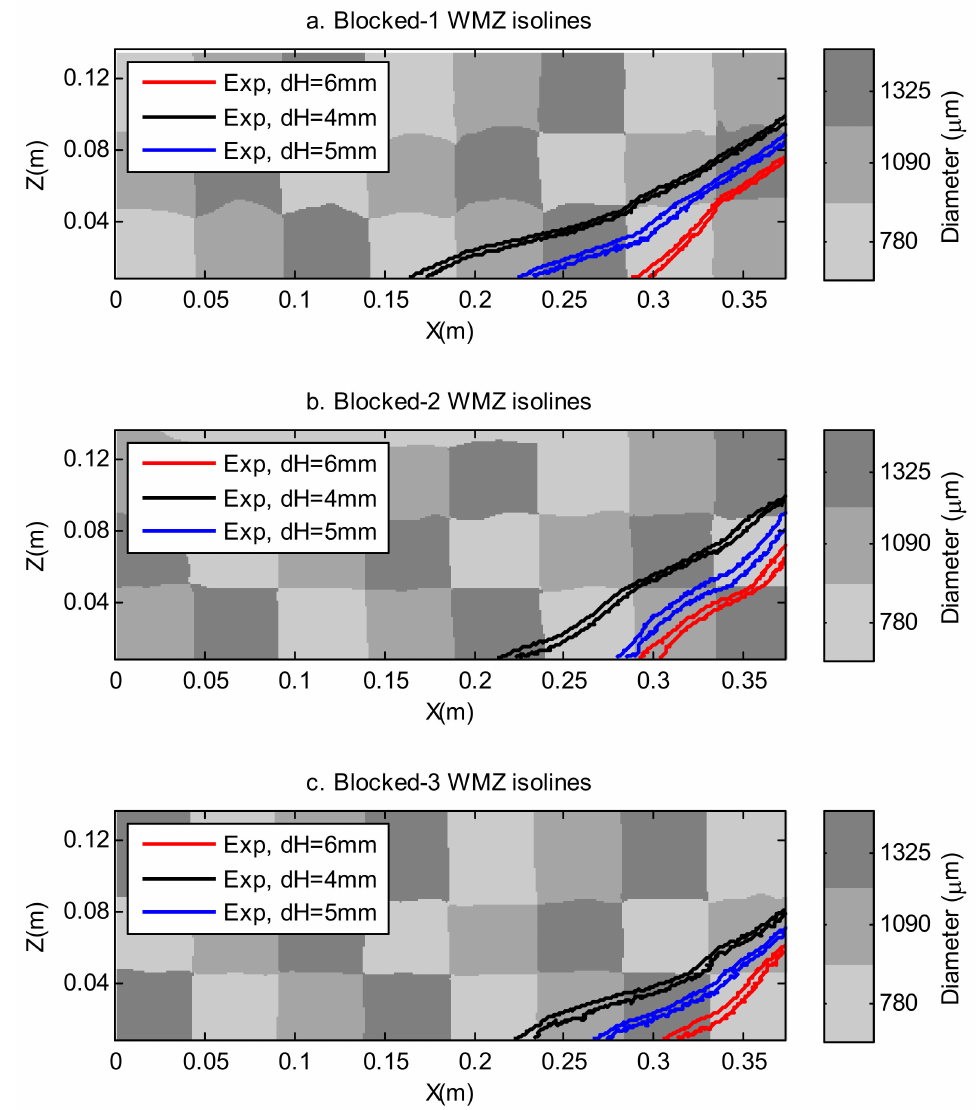
Figure 11. Experimental steady-state 25% (upper line) and 75% (lower line) salt concentration isolines for the Blocked cases at head differences, dH = 6 mm, 4 mm, and 5 mm. (( a ) blocked group 1, ( b ) Blocked group 2, ( c ) Blocked group